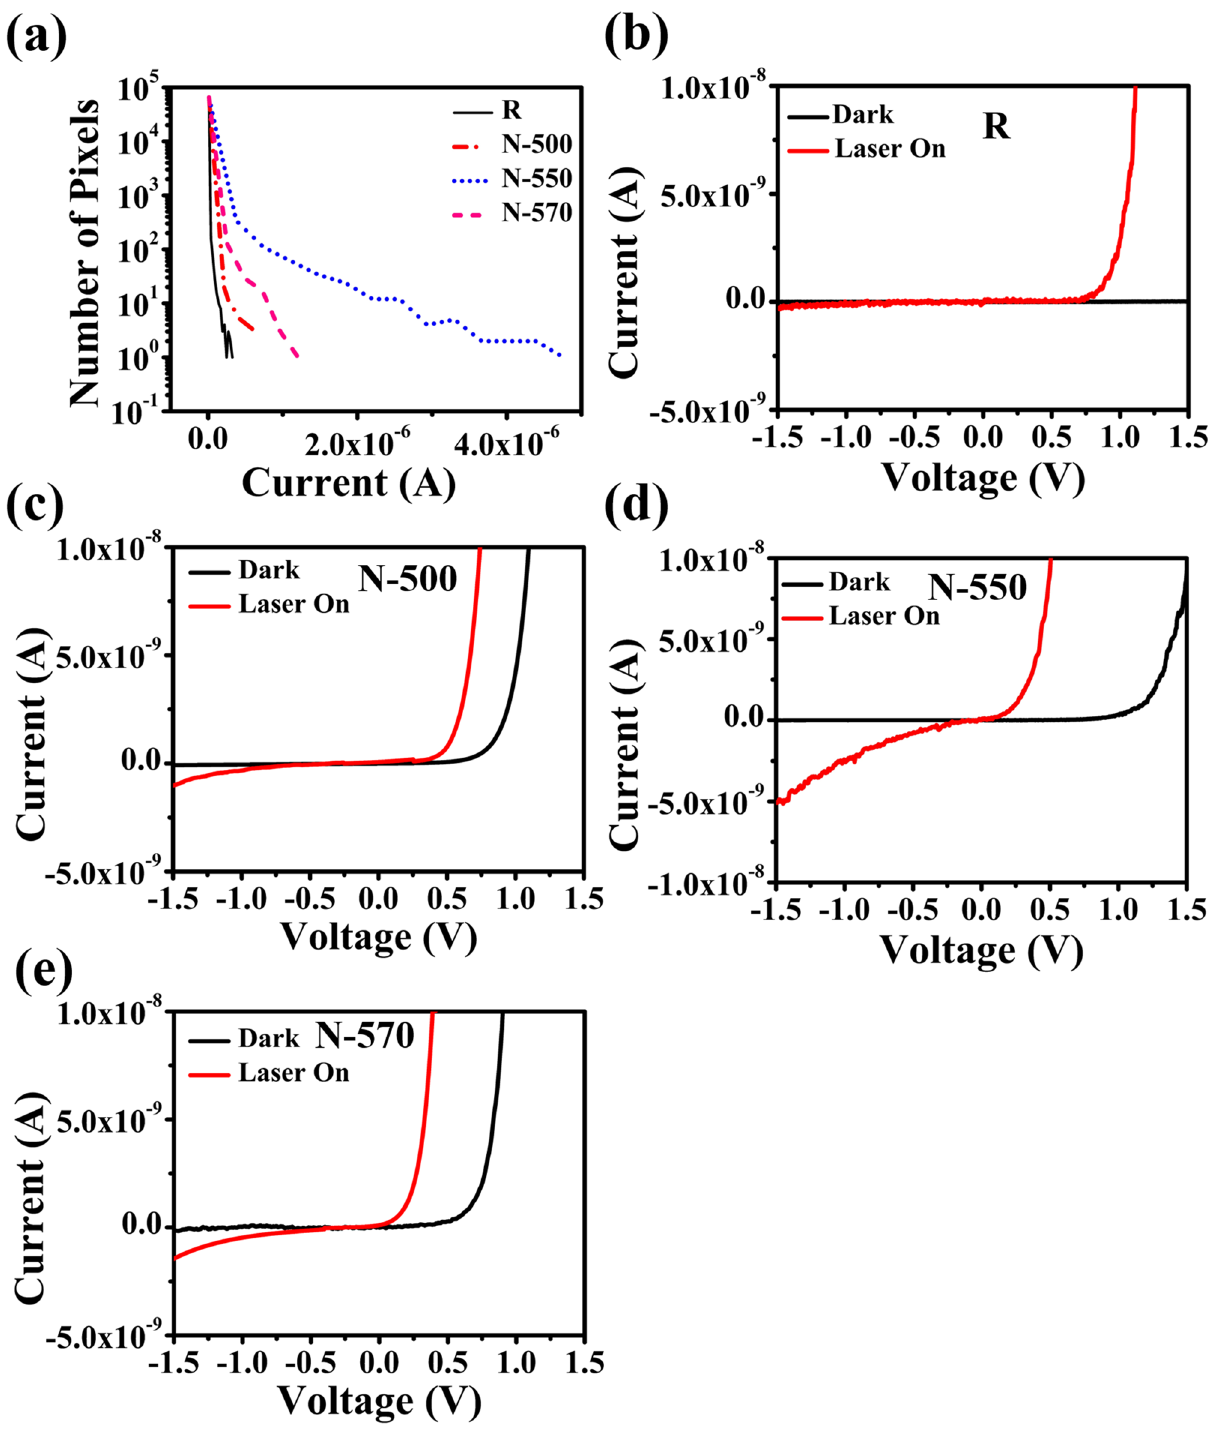
Figure 5. ( a ) Histogram of the current map of samples R, N-500, N-550, and N-570 samples, I–V characteristic of ( b ) R, ( c ) N-500, ( d ) N-550, and ( e ) N-570 samples using